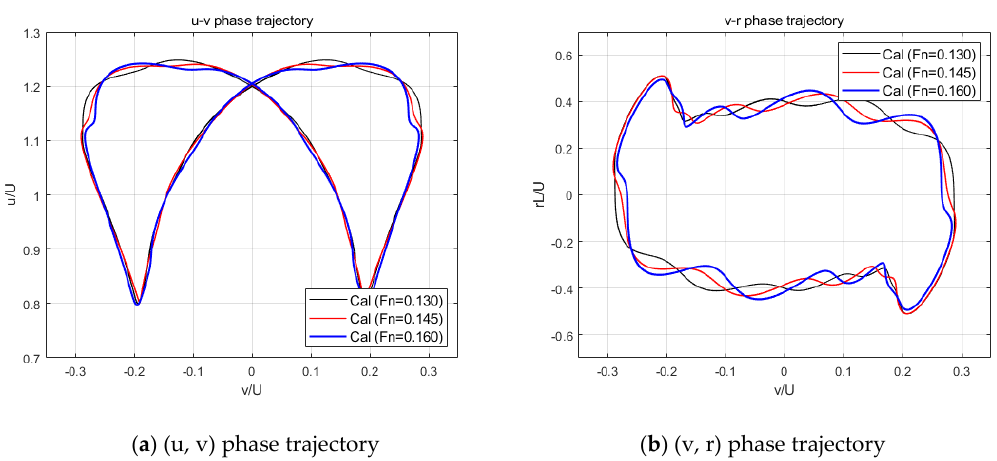
Figure 6. Phase trajectories of the towed vessel under various towing speed conditions ( 𝐿 (cid:3021) 𝐿⁄ = 1.0 )